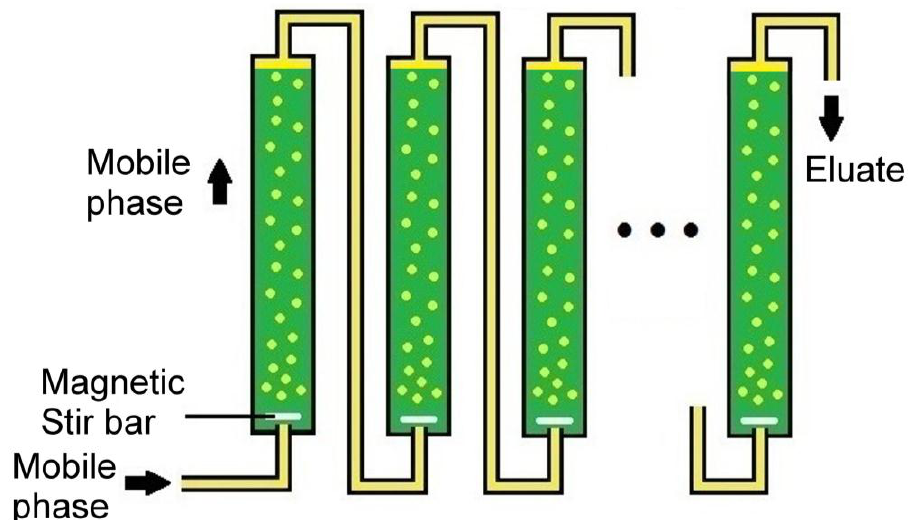
Figure 1. Setup of dispersed mobile-phase countercurrent chromatography (DMCC): A stream of dispersed lighter mobile-phase (yellow) is shown ascending through a series of separation columns, each containing a denser stationary phase (green).